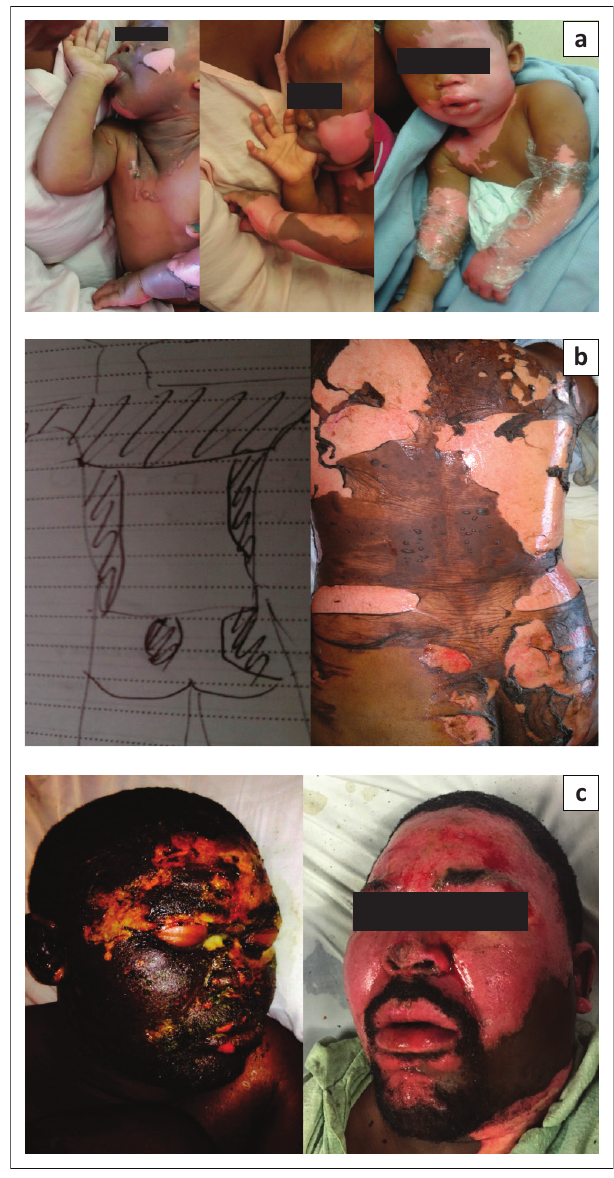
FIGURE 1: The importance of cleaning the burn wound: (a) the actual burn size becomes apparent only after removal of blisters and adequate cleaning, (b) perceived total body surface area by care provider not an accurate reflection of the burn as blisters and non-viable epithelium are not cleaned and (c) only once the wound has been cleaned properly, the superficial partial nature of the burn is